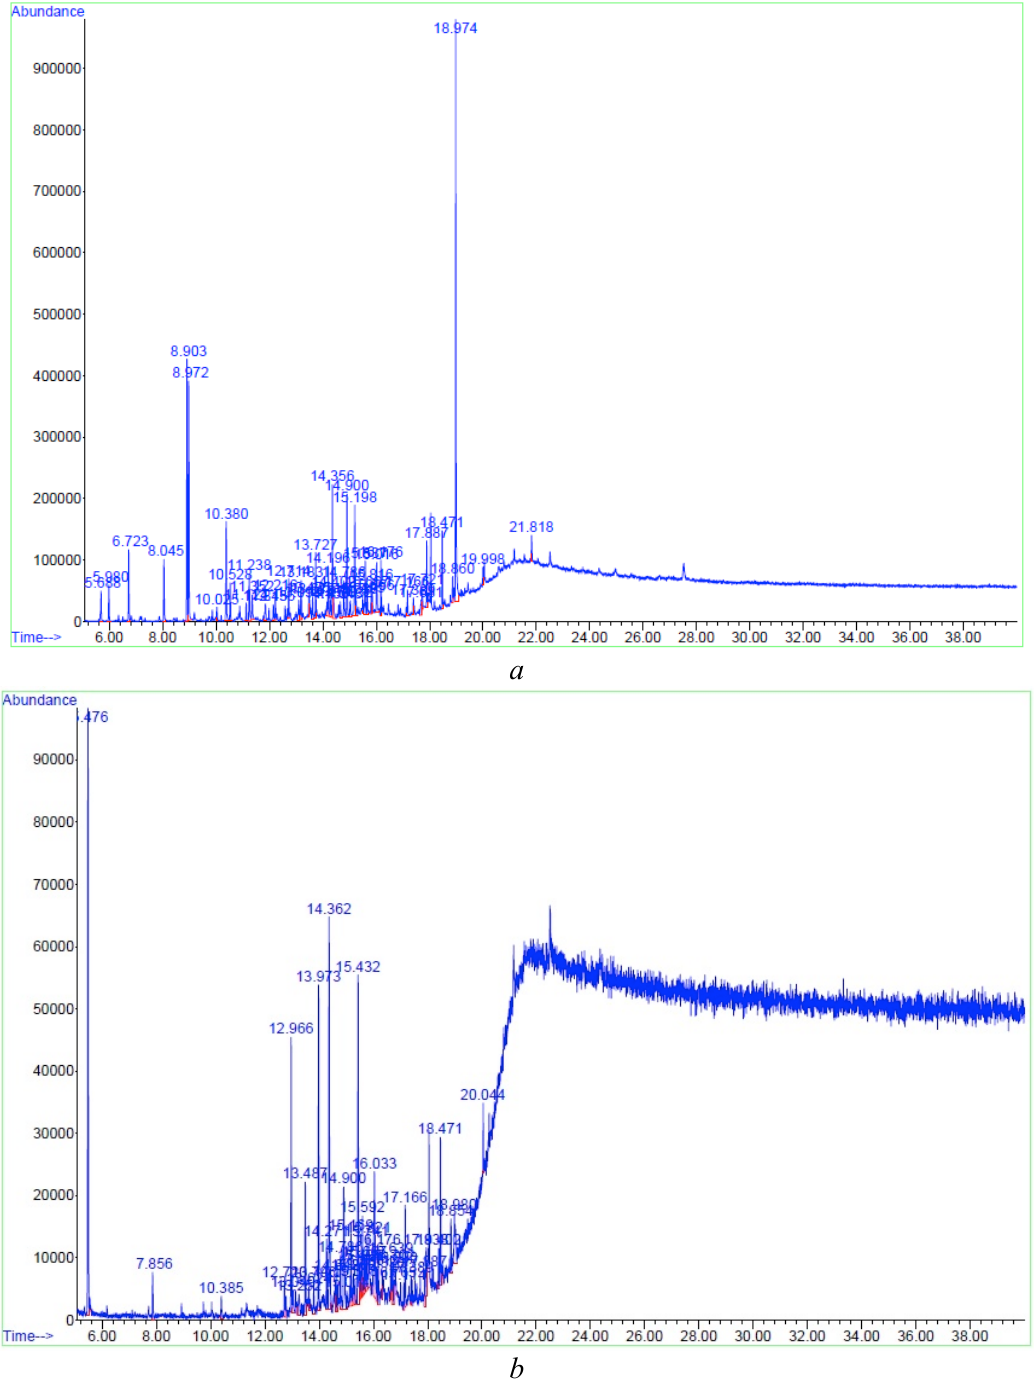
Fig. S1: GS-MS chromatogram of leaves ( a ) and fruits ( b ) of essential oil of F. viridis Weston from sample I